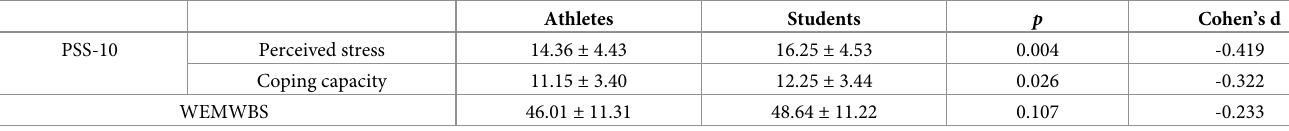
Table 4. Descriptive results of mood of athletes and students ( M ± SD